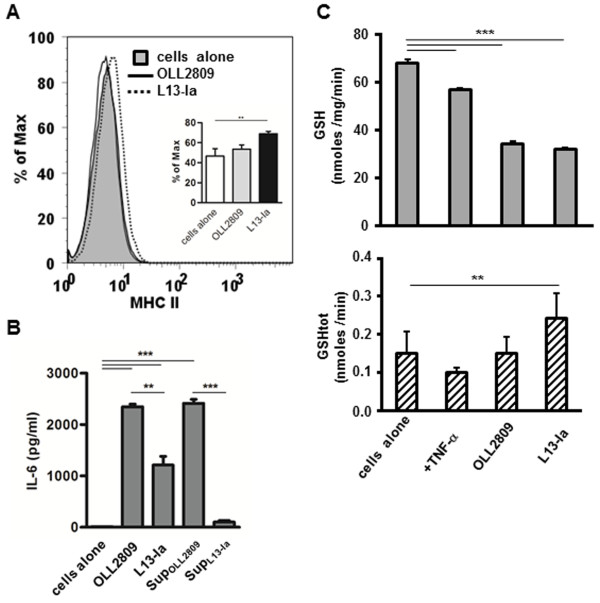
Effects of L. gasseri OLL2809 or L13-Ia on an intestinal cell line. A) FACS analysis of MHC class II expression in MODE-K cells incubated with irradiated L. gasseri OLL2809 or L13-Ia; values are expressed as percentages of the maximal fluorescence intensity. Inset, statistical evaluation of MHC class II expression; columns represent the mean ± SD of three independent experiments; **, P < 0.01. B) IL-6 production by MODE-K cells following 24 h stimulation with irradiated bacteria or their metabolites (SupOLL2809 and SupL13-Ia); values are expressed in pg/ml. C) Intracellular GSH concentration in MODE-K cells, expressed in nmoles/mg prot/min (upper panel), and GSHtot amount in spent media, expressed in nmoles/min (lower panel), following 24 h stimulation with irradiated bacteria; columns represent the mean ± SD and are representative of three independent experiments. sup, supernatant from irradiated bacteria incubated for 24 h in RPMI complete medium. **, P < 0.01; ***, P < 0.001.